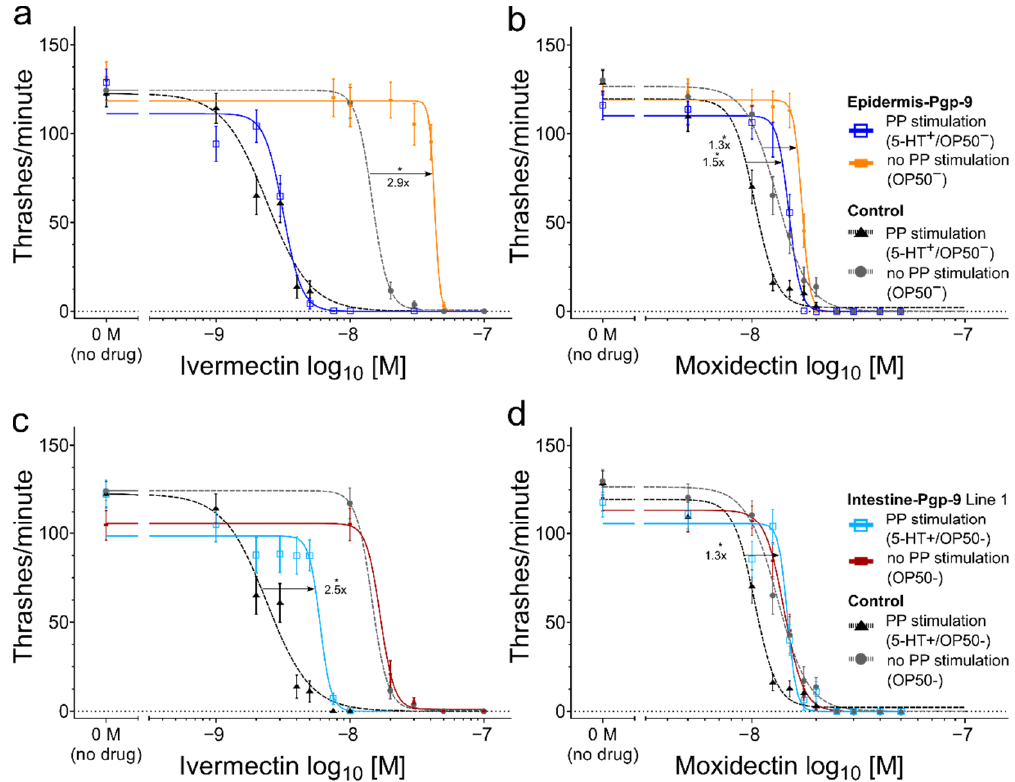
Figure 3. Modulation of ivermectin and moxidectin susceptibility in C. elegans by transgenic tissue-specific Pun -PGP-9 expression. ( a – d ) Concentration–response curves corresponding to Tables 1 and 2 for ivermectin ( a / c ) and moxidectin ( b / d ) in the absence of a PP stimulus (OP50 – ) or PP stimulation by serotonin (5-HT + /OP50 - ) in liquid S-medium. ( a – d ) show the control strain’s re- sponse for 5-HT + (black dashed line with triangles) or OP50 – (grey dashed line with circles), ( a , b )